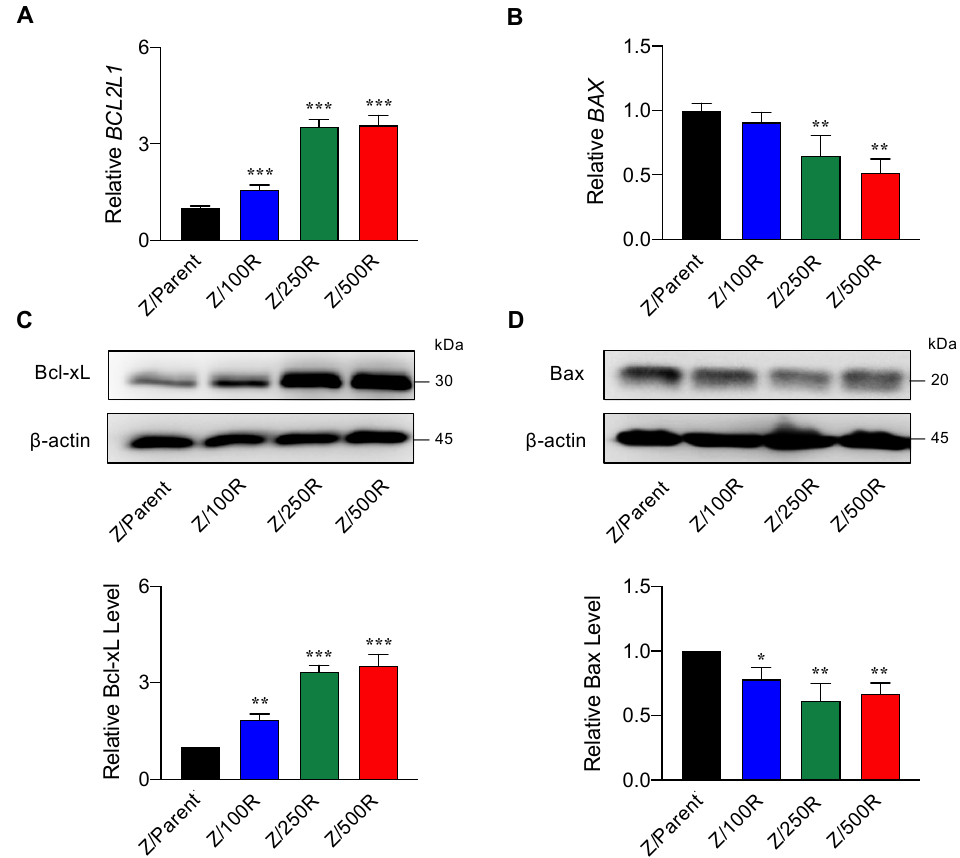
Figure 5. Determination of Bcl-2 and Bax levels in BTZ-resistant cells in comparison to their gene expression. ( A , B ) mRNA expression of BCL2L1 (encodes Bcl-xL) and BAX in parental Z/Parent cells and BTZ-resistant Z/100R, Z/250R, and Z/500R cells using qPCR. Data are mean ± SD ( n = 3). ** p < 0.01, *** p < 0.001 versus Z/Parent cells; two-sided Student’s t -test. ( C , D ) Western blot analysis of Bcl-xL and Bax levels in Z/Parent, Z/100R, Z/250R, and Z/500R cells. Data are mean ± SD ( n = 3). * p < 0.05, ** p < 0.01, *** p < 0.001 versus Z/Parent cells; two-sided Student’s t -test.